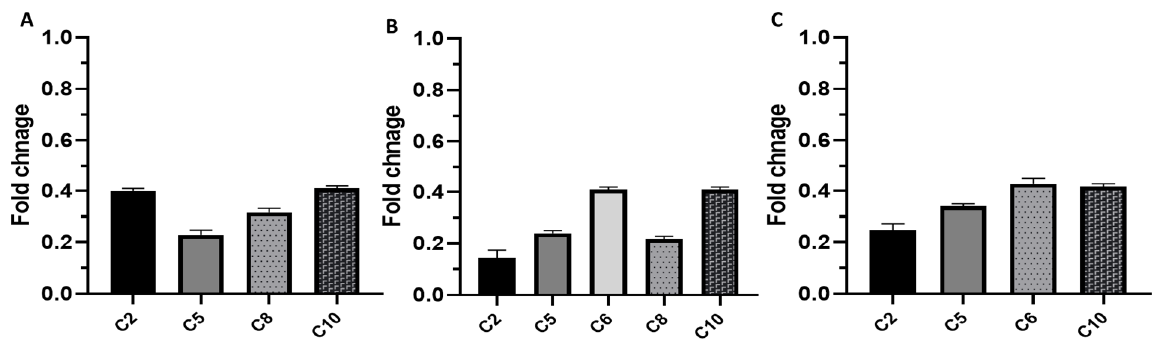
Figure 5. Downregulation of the gene expression of ( A ) CDR1 , ( B ) CDR2 , and ( C ) ERG11 after treatment with EVME in C. glabrata isolates C2, C5, C6, C8, C10.